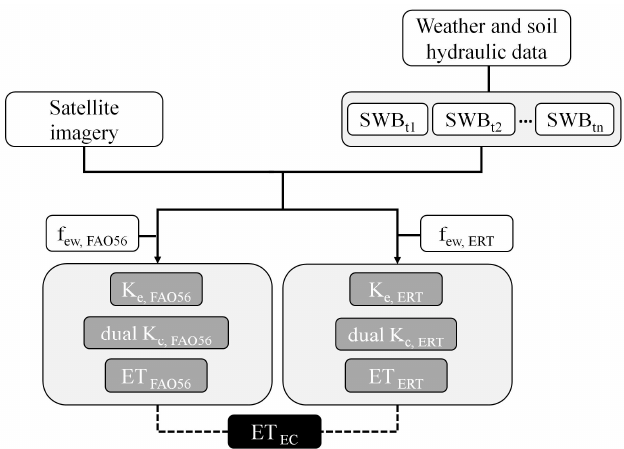
Figure 1. Scheme of the methodology applied in this study.